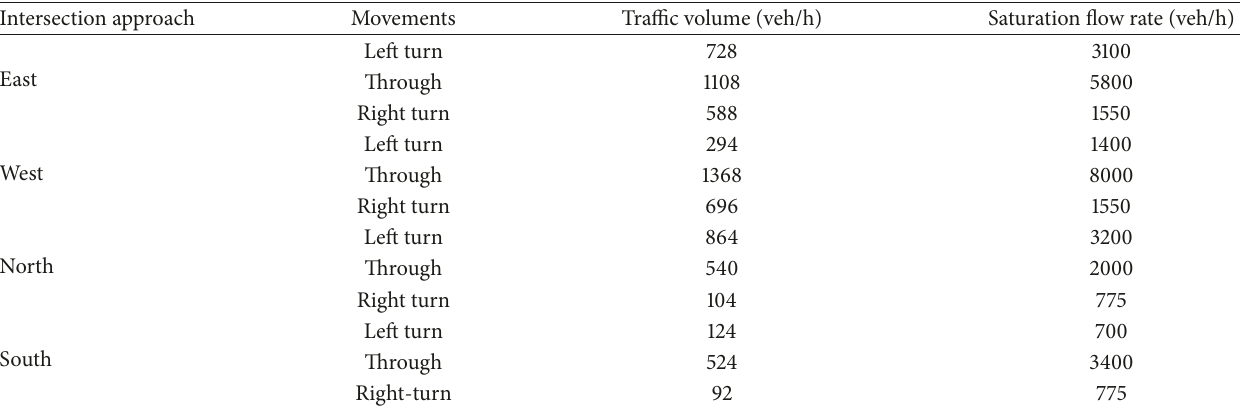
Table 2: Traffic parameters of the tested intersection.